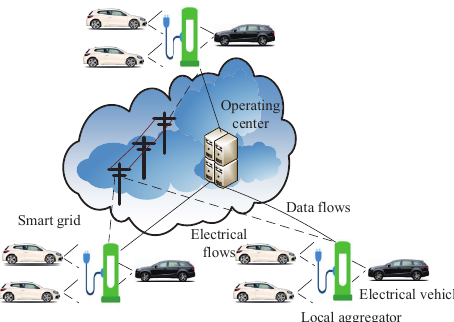
Figure 10. The architecture of vehicle-to-grid networks in a smart grid.